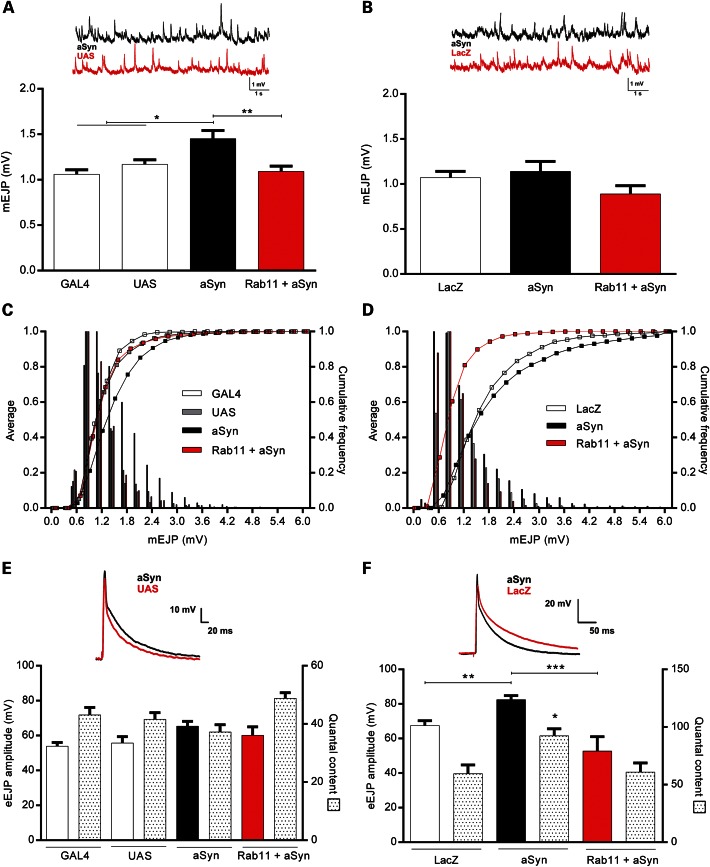
Rab11 reverses aSyn-dependent increases in average mEJP and eEJP amplitudes. Representative mEJP trace and summary graphs of averaged mEJP amplitudes for both Model 1 (A) and Model 2 (B) aSyn transgenic lines and their respective controls in third instar wandering larvae. Pan-neuronal expression of aSyn via the elavGAL4 driver in Model 1 induced a strong increase in mEJPs in aSyn animals. Co-expression of Rab11 with aSyn returned the amplitudes back to control values (N = 8–19). No change was observed in Model 2 (elavGAL4 driver) animals (N = 8–13). Relative cumulative frequency histograms and cumulative frequency curves for the mEJP amplitudes for both Model 1 (C) and Model 2 (D) aSyn transgenic lines and their respective controls are shown. eEJP sample recordings, summary graphs of averaged eEJP amplitudes and QC for Model 1 (E) and Model 2 (F) aSyn transgenic lines corrected for non-linear summation, which takes into account any changes in resting membrane potential. Pan-neuronal expression of aSyn via the elavGAL4 driver in Model 2 aSyn animals induced an increase in eEJPs and QC (F; N = 6–13). Co-expression of Rab11 with aSyn led to a reduction and normalization of eEJP amplitudes in the φC31 animals. No change was observed with Model 1 larvae regarding eEJP amplitudes or QC (E; N = 5). Data are mean ± SEM. ANOVA with Newman–Keuls post hoc tests. *P < 0.05, **P < 0.01 and ***P < 0.001.